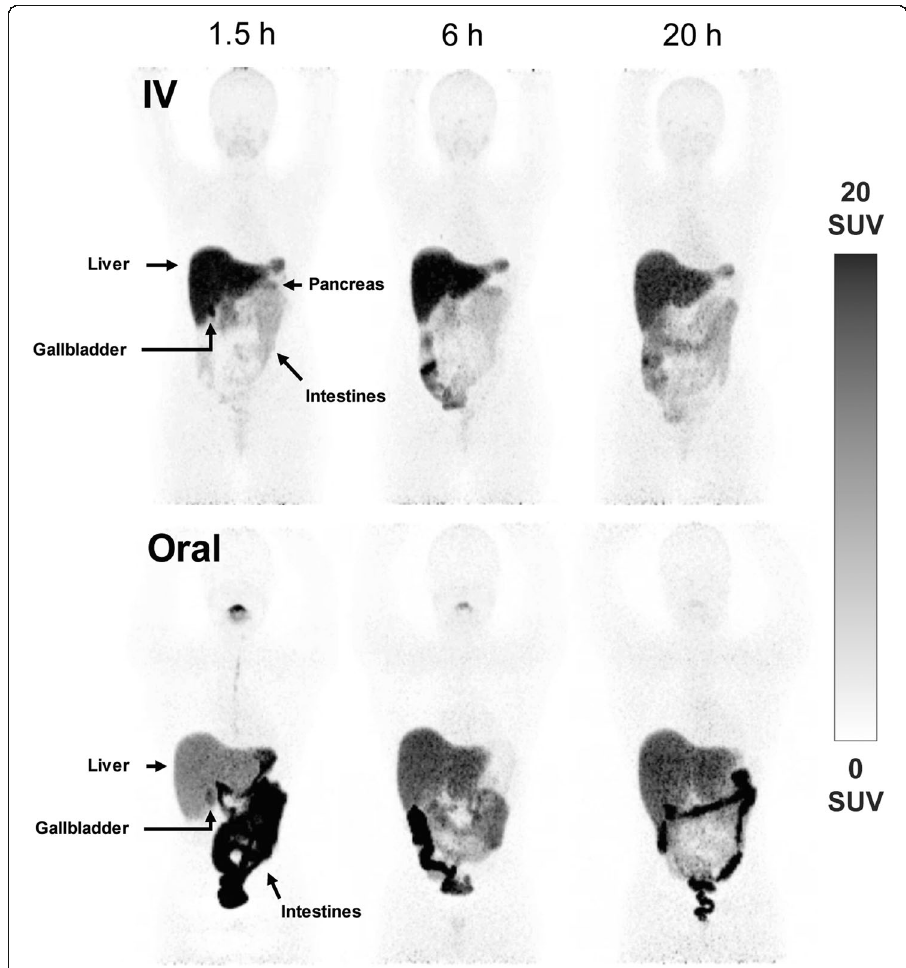
PET imaging was performed 1.5, 6, and 20 h after administration. Arrows identify most visible source